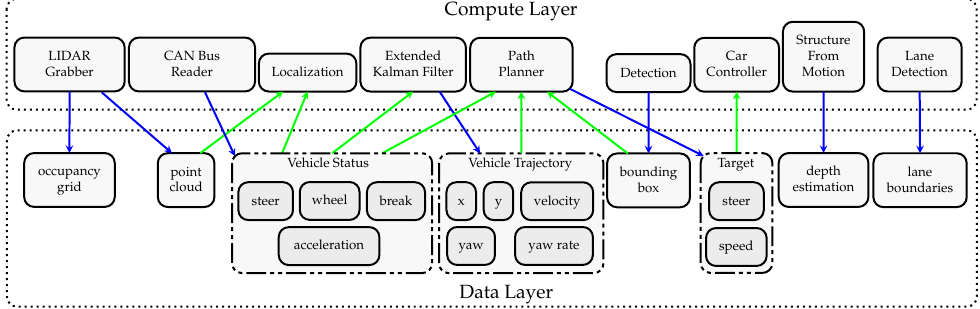
Figure 14. Access pattern of the examined autonomous driving application [62].